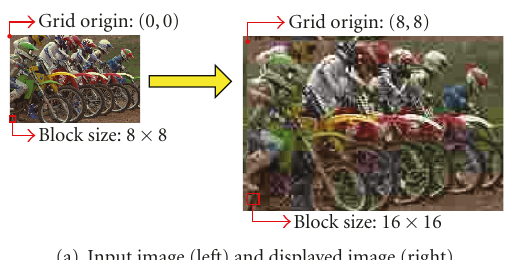
(b) 1-D signal formation: S, MS and PS are calculated according to (2) and (3) for the displayed image in (a) along the horizontal direction